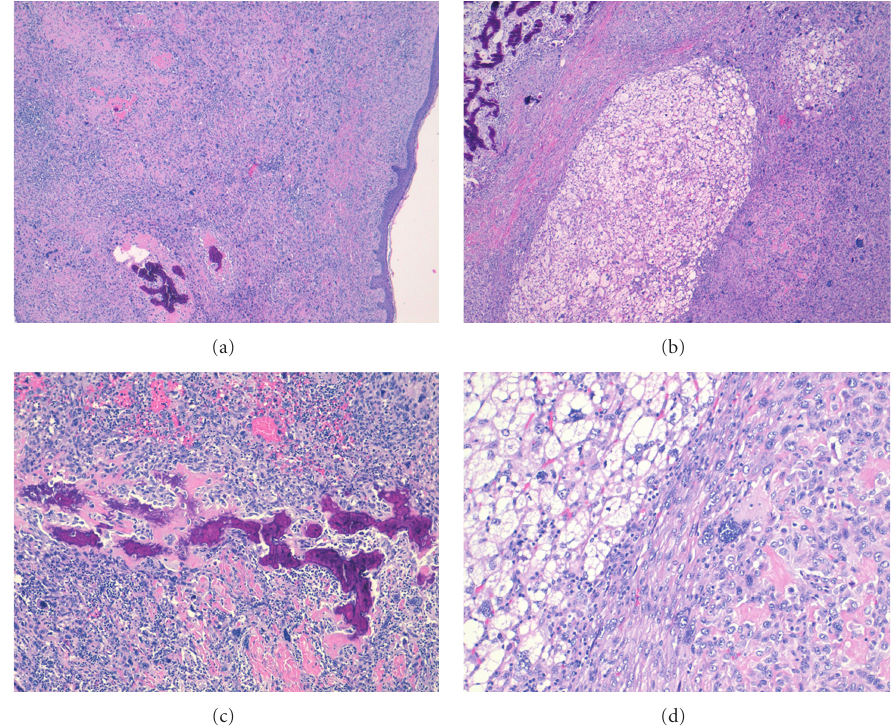
Figure 2: Histopathologic findings. (a) Sarcoma showing no relation with epidermis (noted a focus of osteosarcoma is present). (b) Combined sarcoma showing liposarcoma and osteosarcoma zones. (c) Typical calcified osteoid in conventional osteosarcoma. (d) Atypical pleomorphic lypoblasts adjacent to osteoid